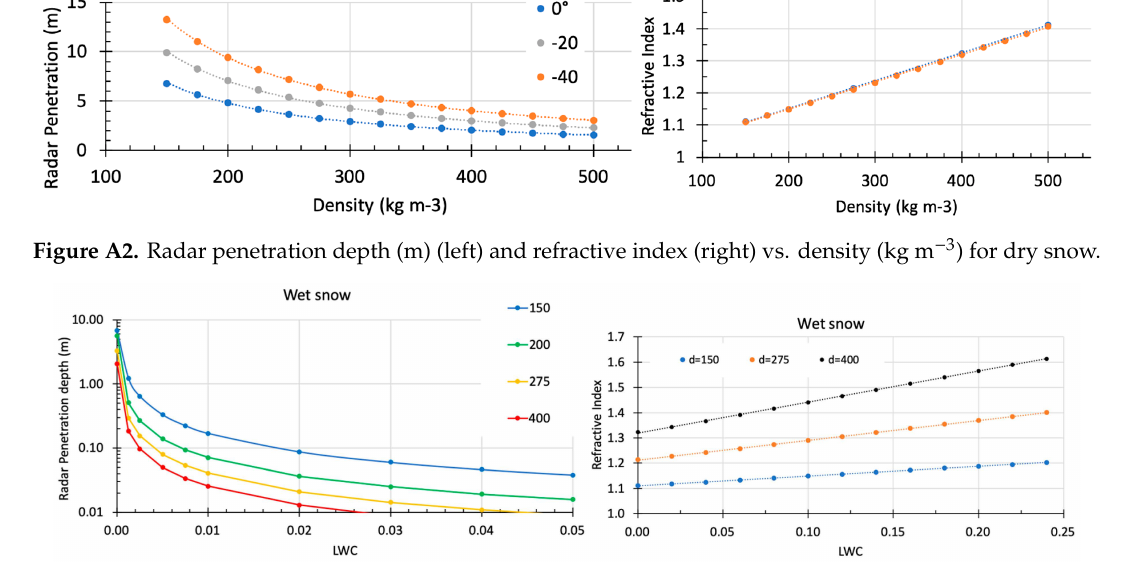
Figure A3. Radar penetration depth (m) (left) and refractive index vs. liquid water content (LWC) (fraction of volume) for wet snow at four densities: 150, 200, 275 and 400 kg m − 3 .